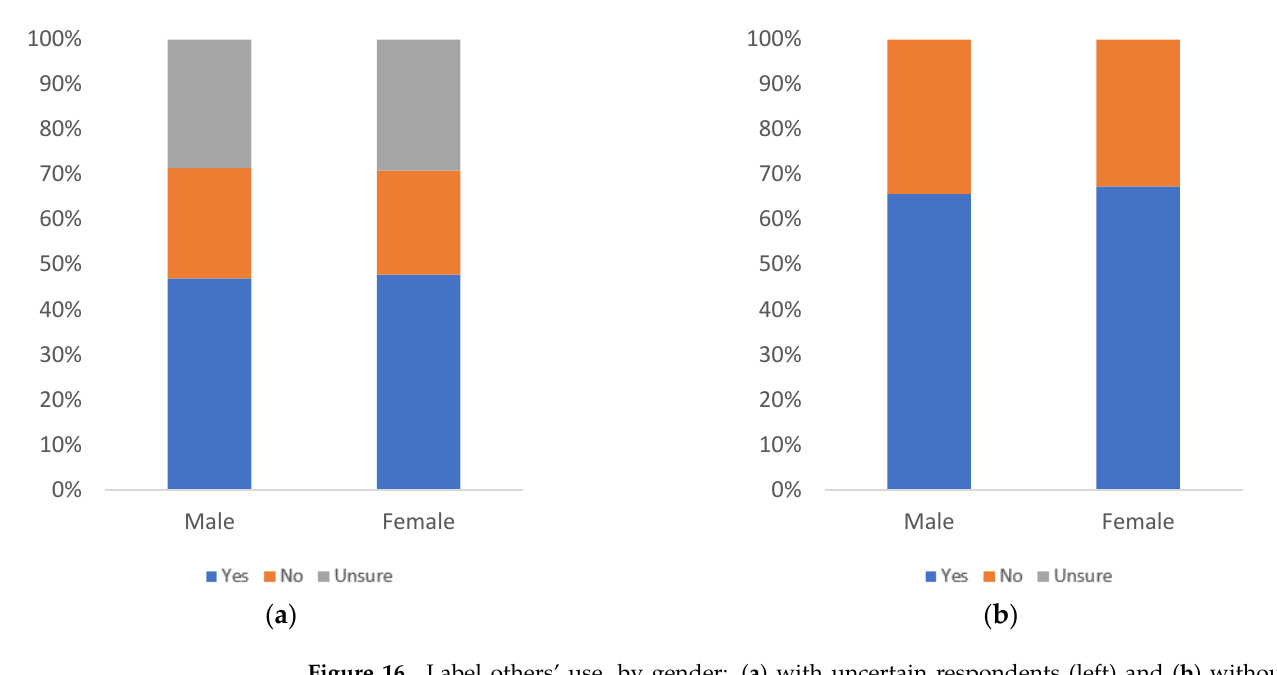
Figure 16. Label others’ use, by gender: ( a ) with uncertain respondents (left) and ( b ) without uncertain respondents (right).